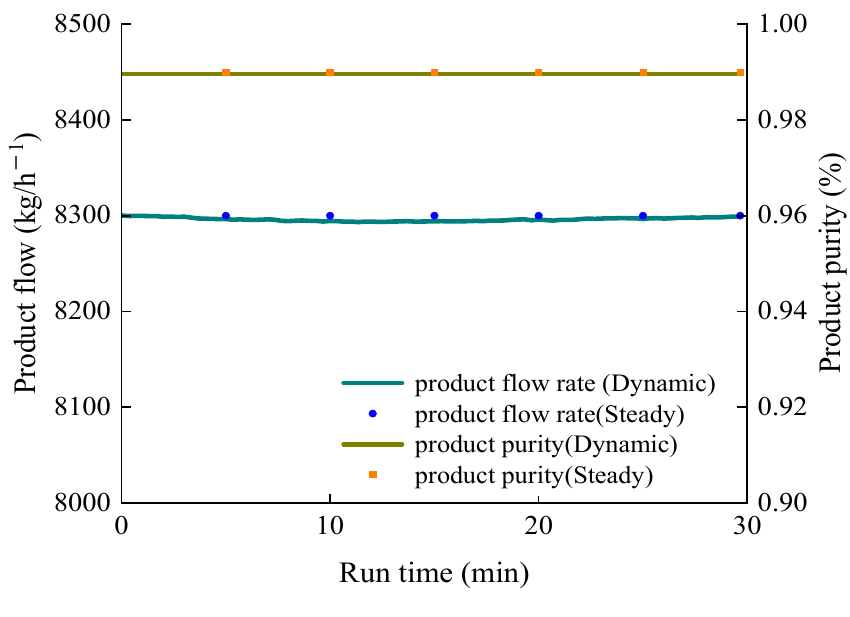
Figure 4. Dynamic model validation.